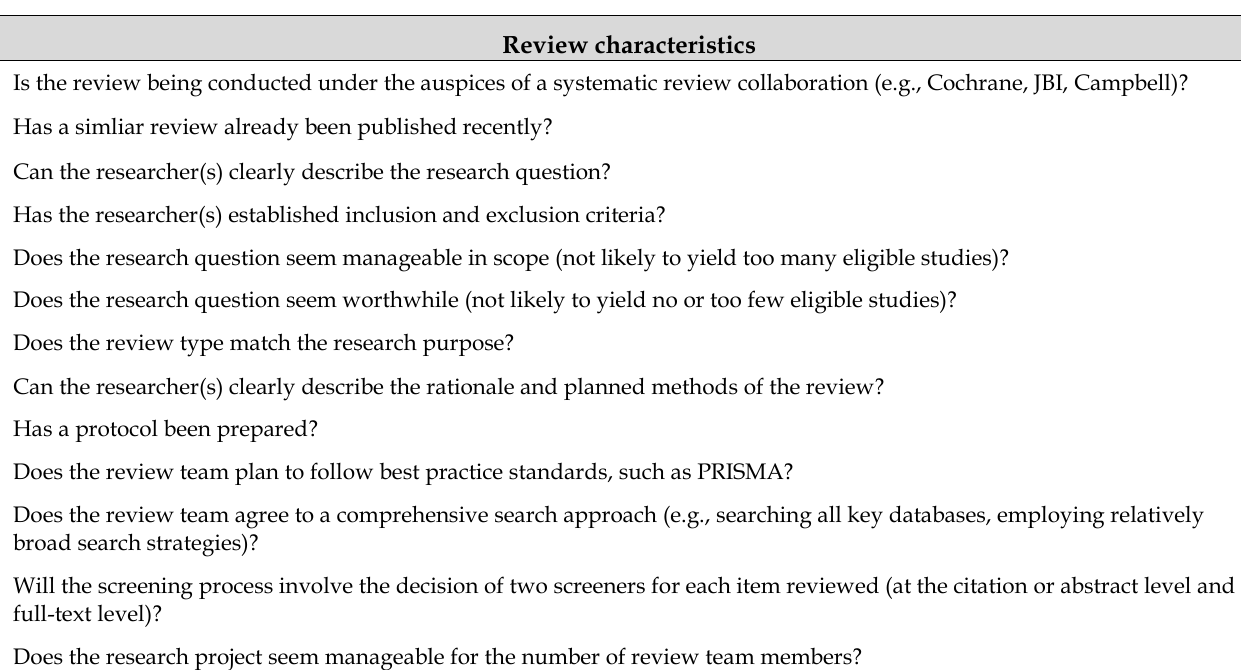
Table 2 Review characteristics for librarian collaboration